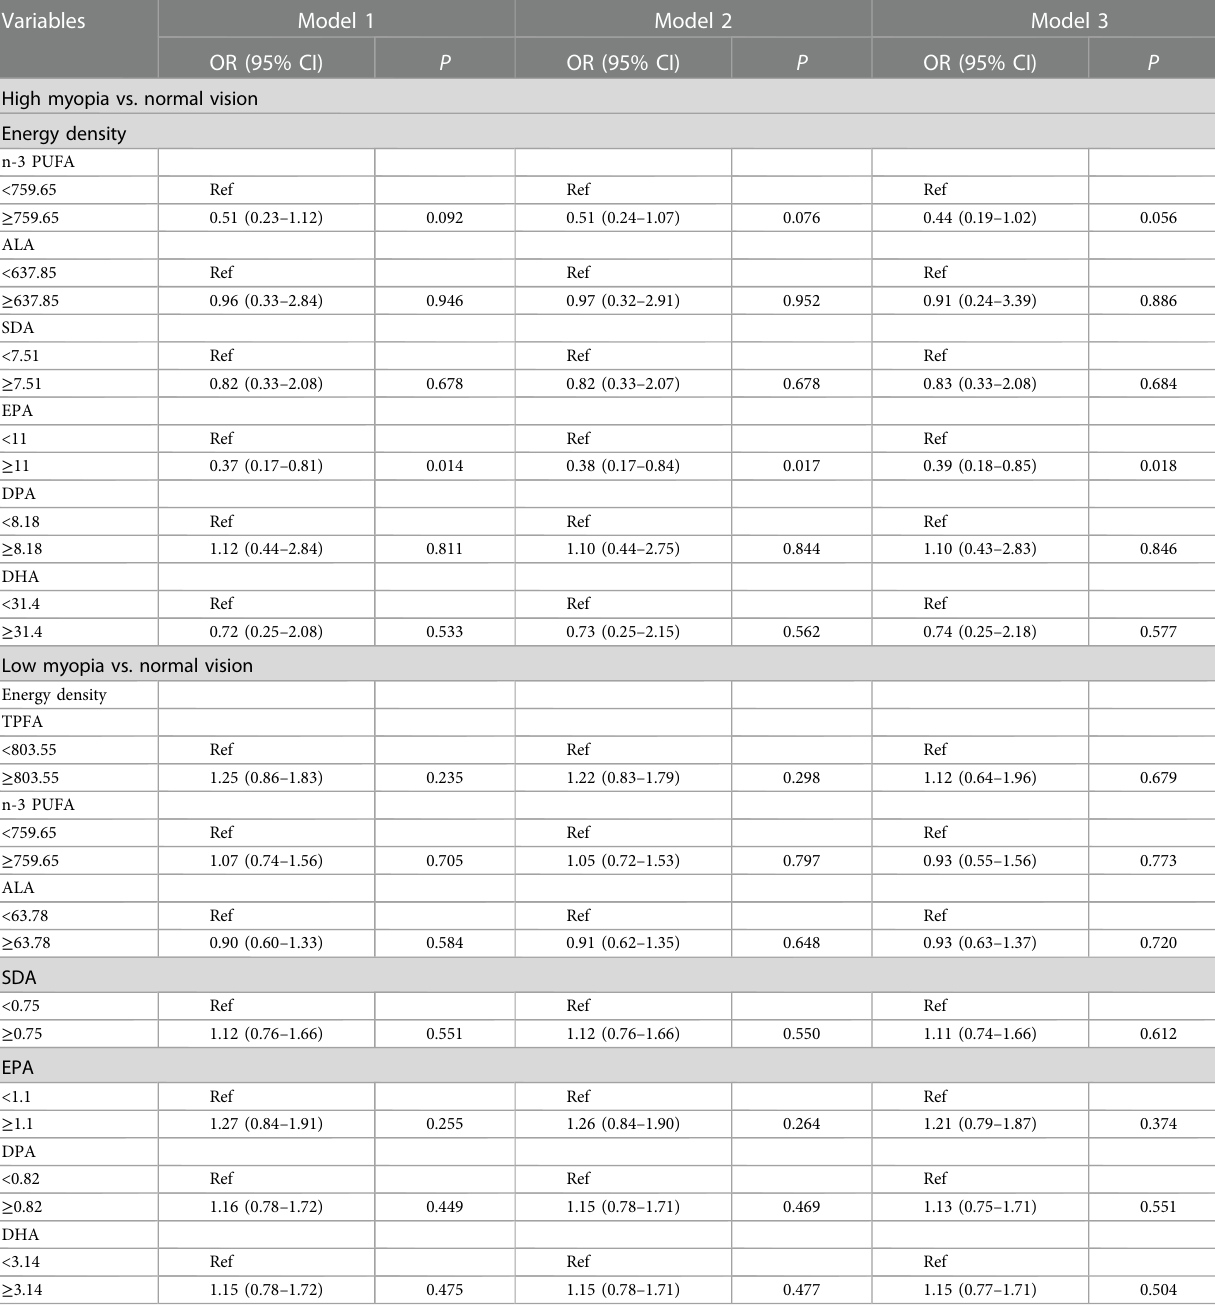
TABLE 3 Association between n-3 PUFA intakes and the risk of juvenile